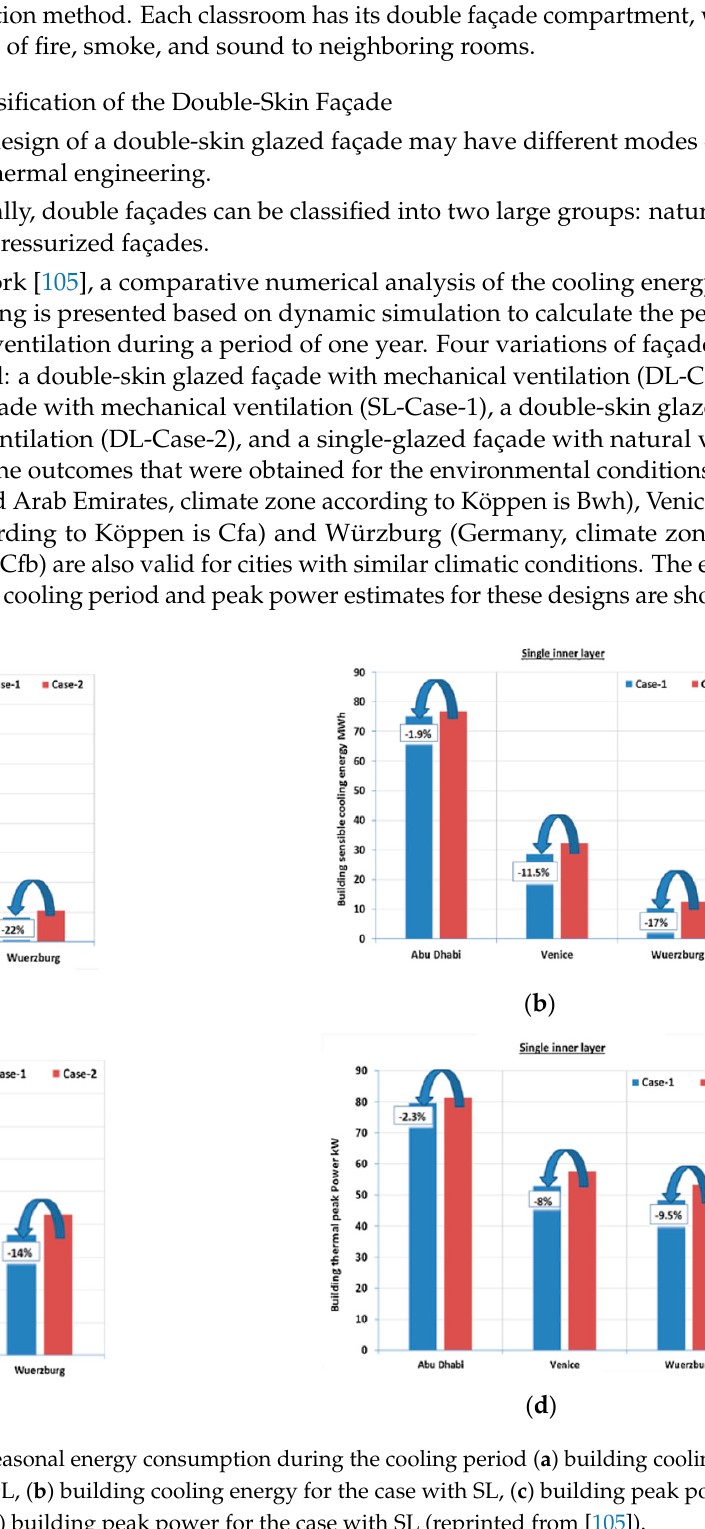
( d ) Figure 9. Scheme of double-skin façade operation ( a ) mode A, ( b ) mode B, ( c ) mode C, ( d ) mode D (data from ref. [34,106,107]) . In mode A, room air circulates in the air duct, passing into the HVAC system. The air enters the duct through the lower opening on the inner façade, then it rises and passes into the HVAC. In mode B, fresh air enters the duct through the outdoor duct. In winter, fresh air can be preheated before entering the room. Types A and B are mechanically ven- tilated. DSF is easily integrated with the building ’ s HVAC system. In mode C, the air heats up and rises naturally. Fresh air can be supplied to the room from the street with an open window on the inner façade. If all the windows on the inside of the façade are closed, then the outer wall becomes isolated from the inner space. In this way, the thermal impact on the building during hot periods can be reduced.